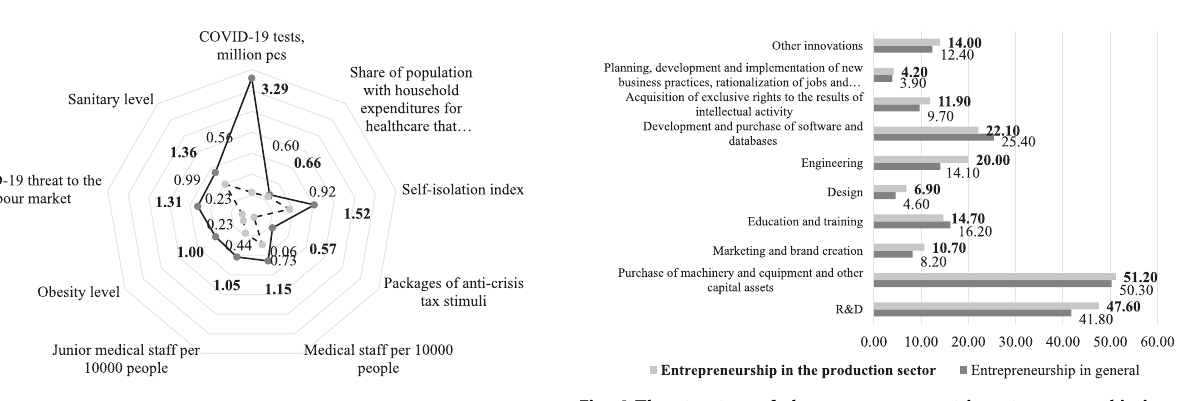
Fig. 4 The structure of change management in entrepreneurship